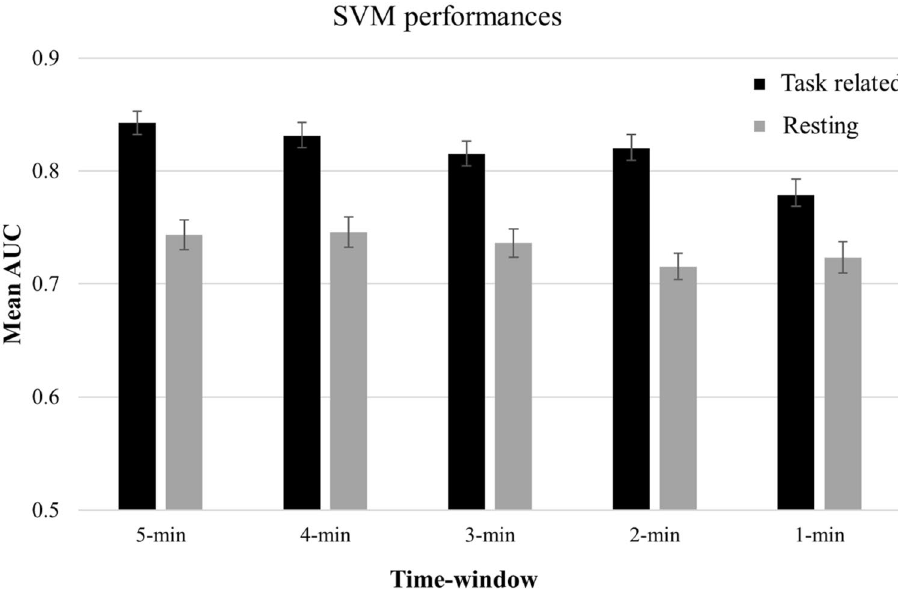
Figure 3. Performances of the support vector classifiers in each classification problem. Error bars represent the 95% confidence intervals AUC area under the receiver operating characteristic curve, SVM support vector machine.